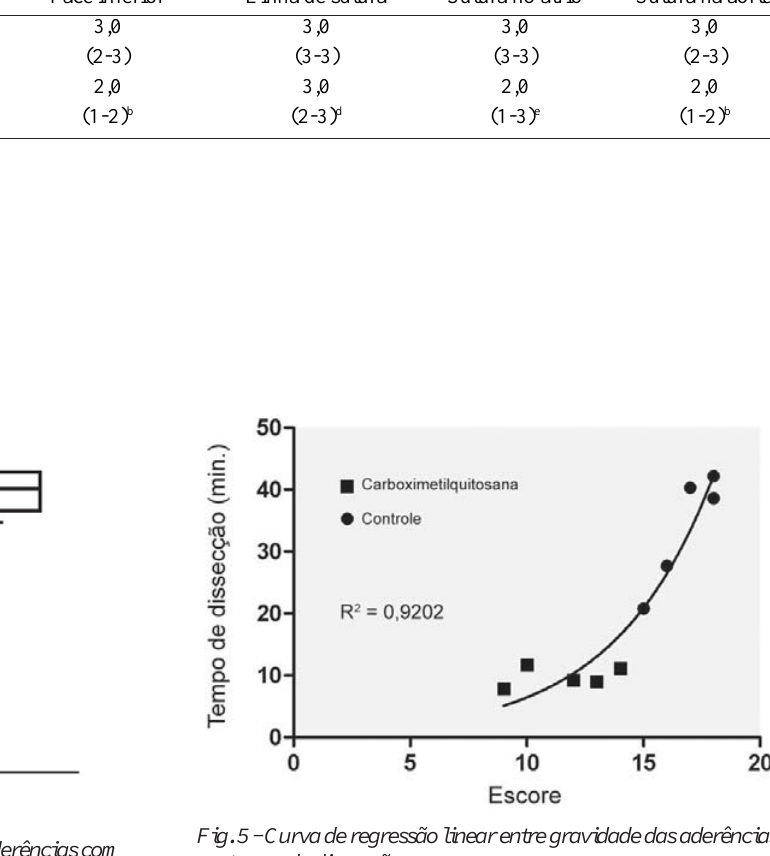
Fig. 4 - Análise macroscópica da intensidade das aderências com